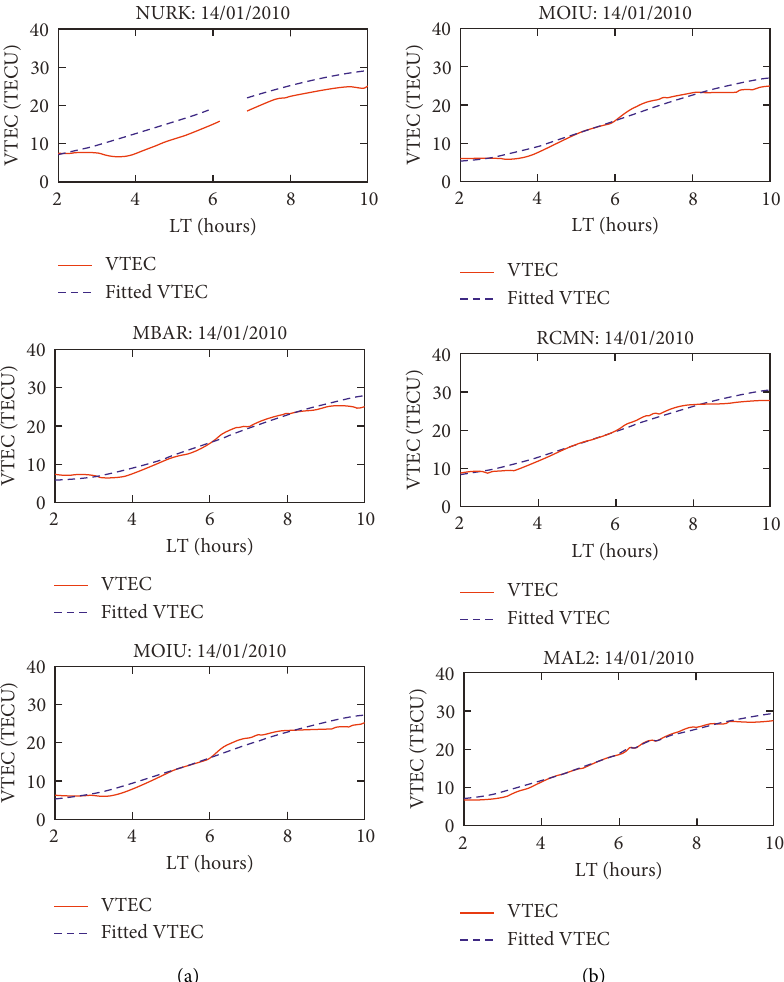
Figure 8: VTEC and fitted VTEC against local time (LT) across (a) NURK-MBAR-MOIU and (b) MOIU-RCMN-MAL2 GPS array on 14 th January